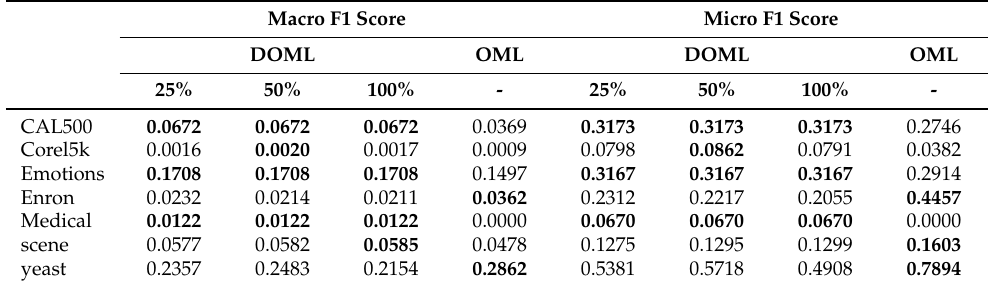
Table 8. F1 Score of DOML in a 100-node network with different connectivity and OML with the same amount of instances as each node.